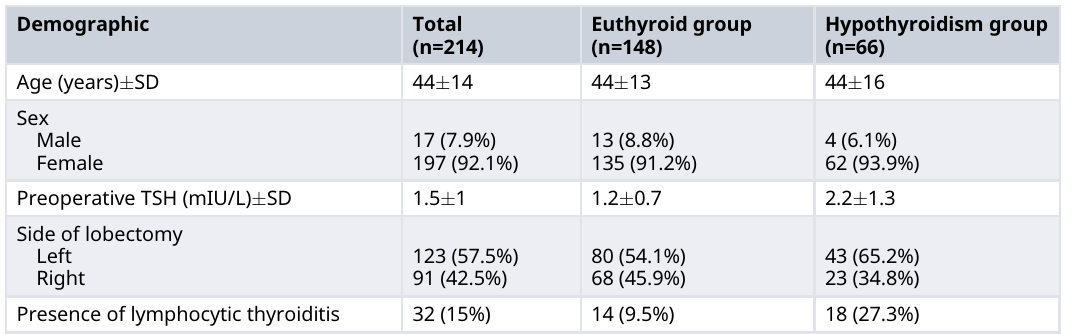
Table 1. Initial characteristics of the studied